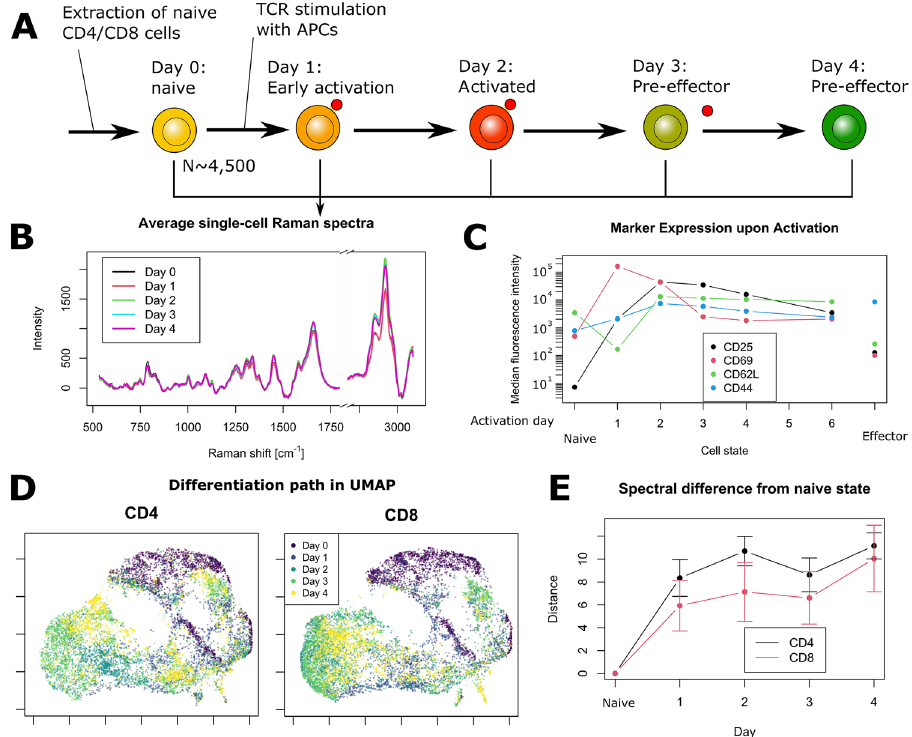
Figure 1. Early T cell differentiation monitored with Raman spectroscopy. ( A ) Experimental protocol, where murine T cells are stimulated with artificial APCs and measured everyday during 5 days. ( B ) Average single- cell Raman spectra (approximately 2000 cells per day and per type), showing that only small changes can be observed during the onset of activation. ( C ) Median fluorescence intensity signal derived from the expression of surface markers of CD4 cells over time, representative of T cell activation and differentiation. ( D ) UMAP decomposition of Raman data, where the gradual evolution of the signal upon activation can be readily observed. Differences between phenotypes (CD4/CD8) are also clearly visible. All results are representative of at least 3 experiments. ( E ) Quantification of the daily signal changes with the Mahalanobis-like distance. Curves are the average of 3 experiments, error bars indicate standard